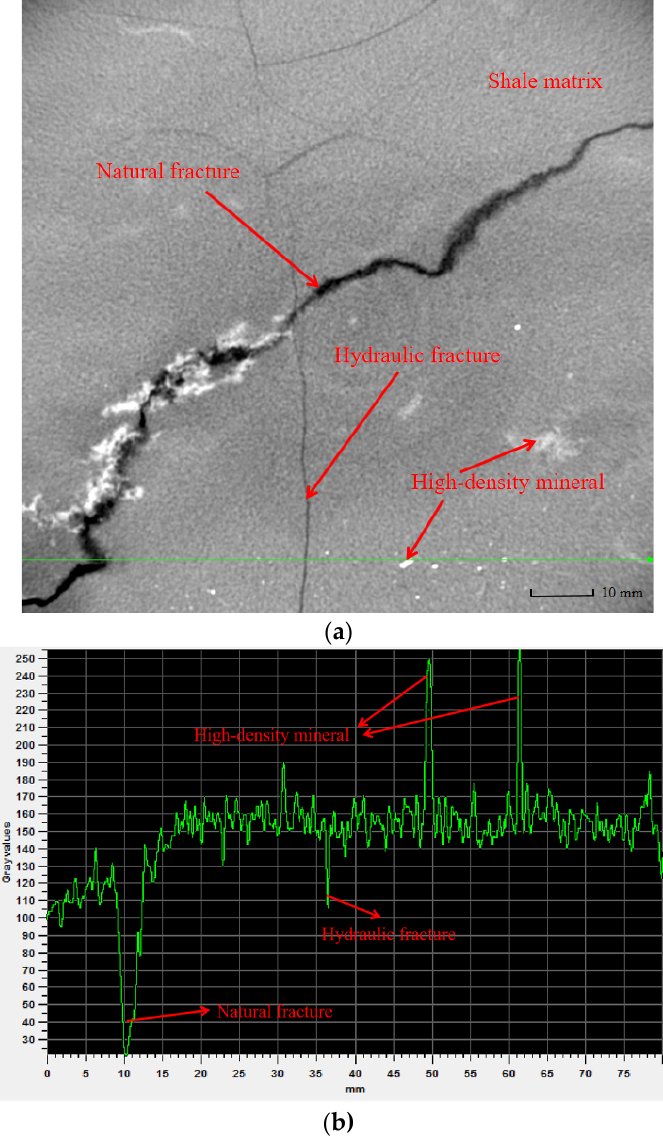
Figure 2. The section line and gray value curve of sample H3. ( a ) The section line of sample H5 (794th layer slice). ( b ) The gray value curve of the 794th layer